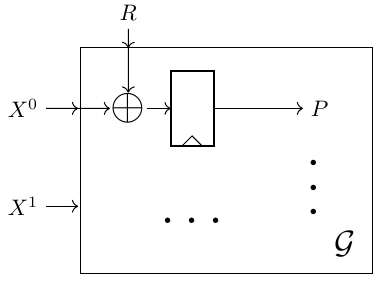
Figure 3: Example probe on a